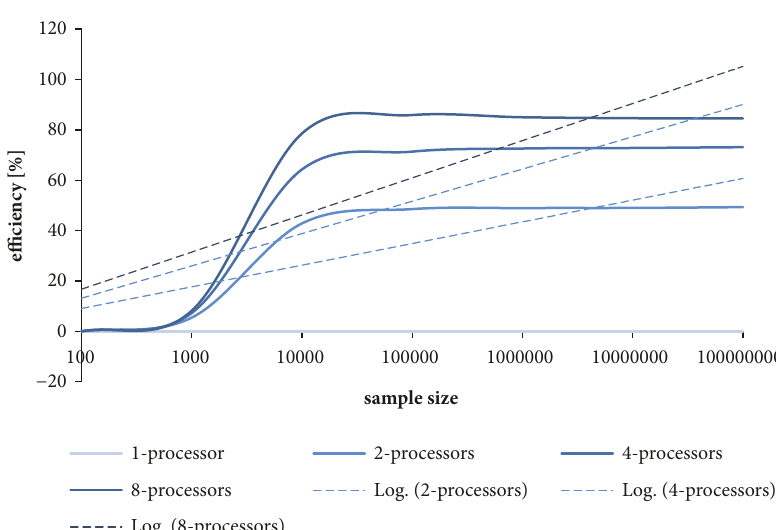
Figure 13: Comparison of benchmark operations [ti].